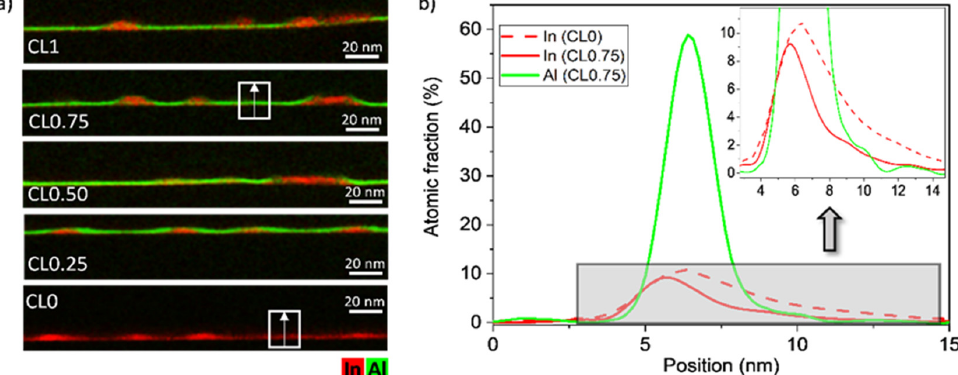
Figure 4. ( a ) Elemental EDX maps of In and Al for the different QD layers. ( b ) Average compositional profiles of In (red) and Al (green) along the growth direction in the CL/WL regions of the QD layers CL0.75 and CL0. All the compositional profiles of the QD layers with CL of AlAs in the regions between dots are remarkably similar. The inset corresponds to a zoom of the gray region.